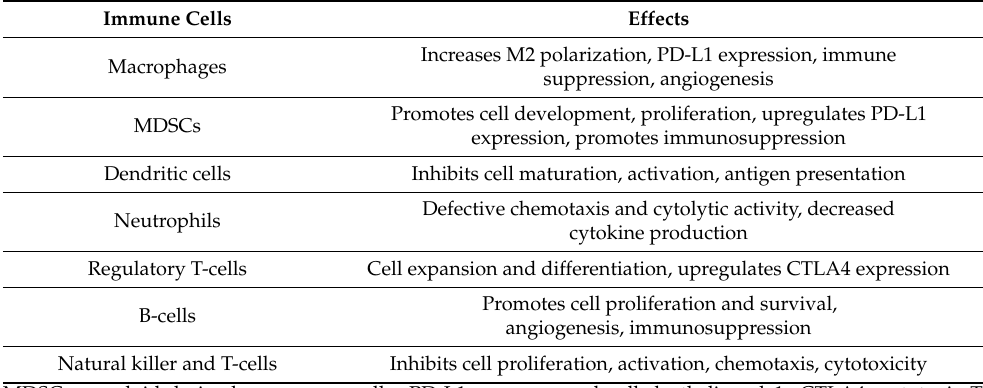
Table 1. Cancer-related effects of activated STAT3 in immune